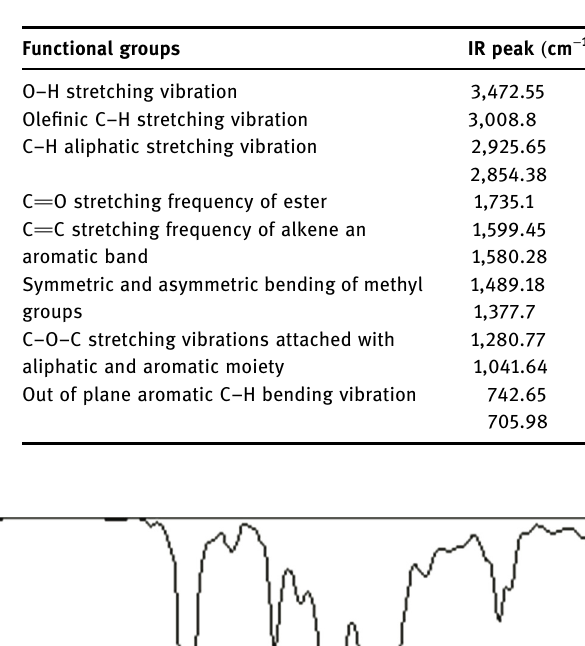
Table 3: IR spectral of new HECA modi fi ed alkyd showed